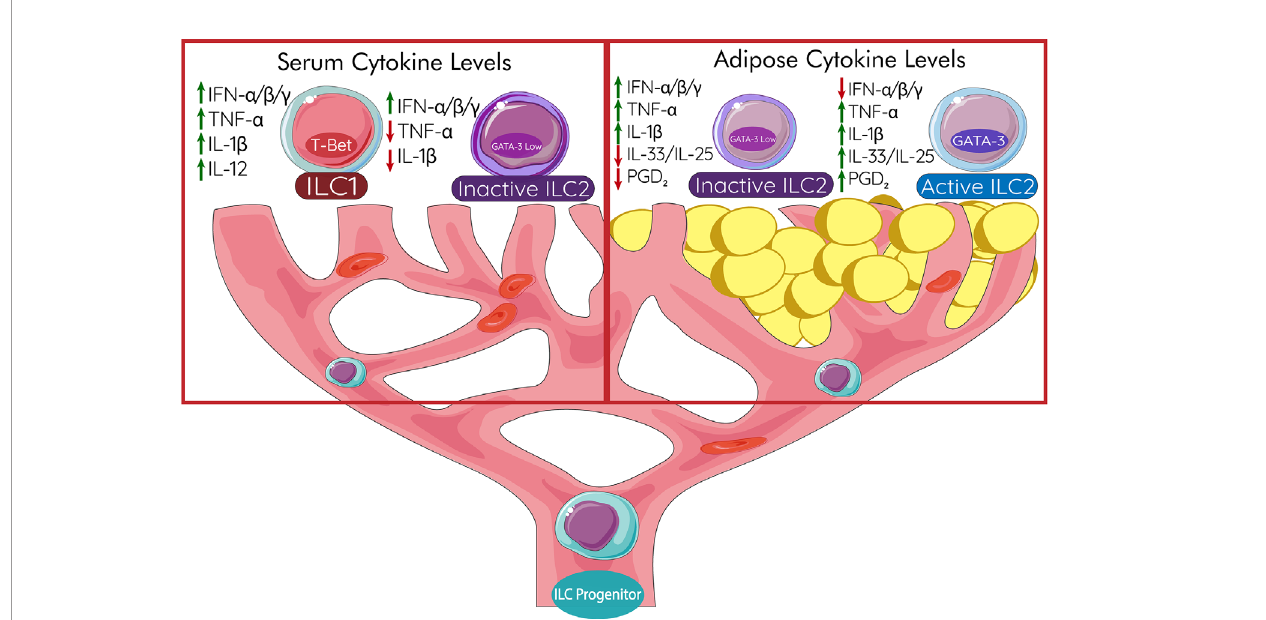
FIGURE 3 | ILC2 Traf fi cking and Maintenance in Adipose Tissue. ILC progenitors are able to traf fi c from the bone marrow to their resident tissue to replenish and restore type 2 responses. In the blood, cytokine levels affect the outcome of these progenitors due to their natural plasticity. ILC progenitors exposed to high IFN, TNF- a , IL-1 b , and IL-12 will develop into ILC1s. While ILC2s could still develop, high IFN- a / b / g levels greatly decrease the effector function of ILC2s rendering them inactive. Once arrived in the adipose tissues, low IL-33 and PGD2 effects the number and function of ILC2s. High TNF- a , IL-1 b , IL-33, and PGD 2 generate active ILC2s able to protect adipose from dysfunction responsible for T2DM. IFN, interferon; IL, interleukin; ILC, innate lymphoid cell; ILC1, type 1 innate lymphoid cell; ILC2, type 2 innate lymphoid cell; PGD 2 , prostaglandin D2; T-bet, t-box transcription factor TBX21; TNF- a , tumor necrosis factor alpha; Treg, regulatory T